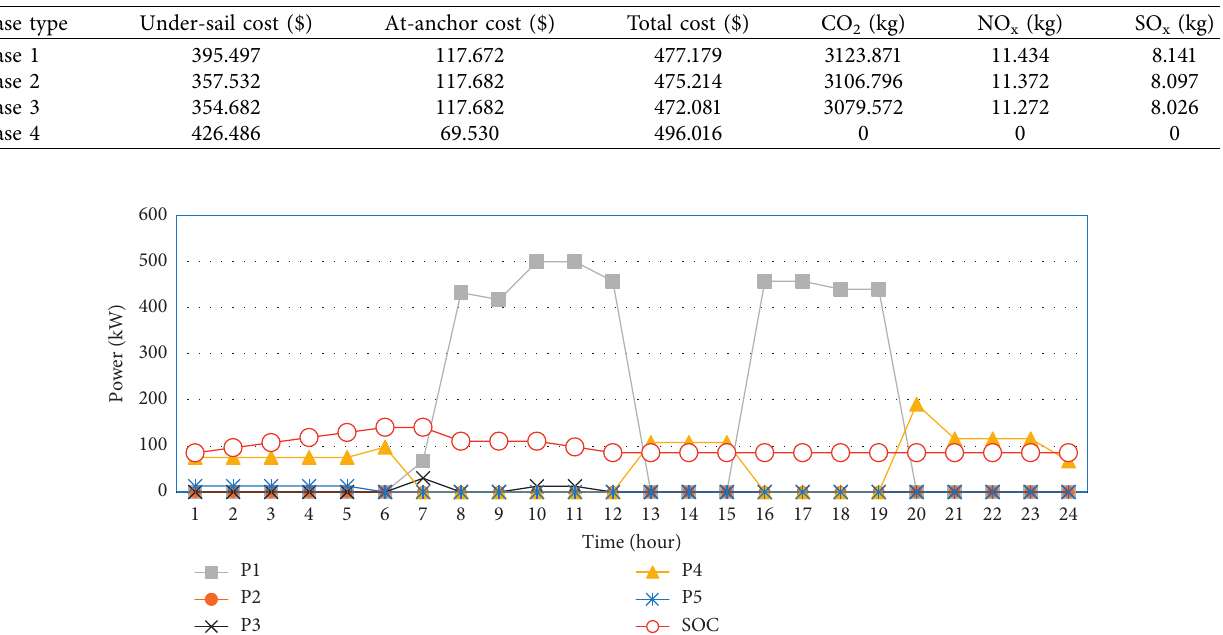
Figure 12: Output power of FCs and consumed hydrogen in case 4. Table 3: Comparison of total costs and emission factors for different energy management strategy.